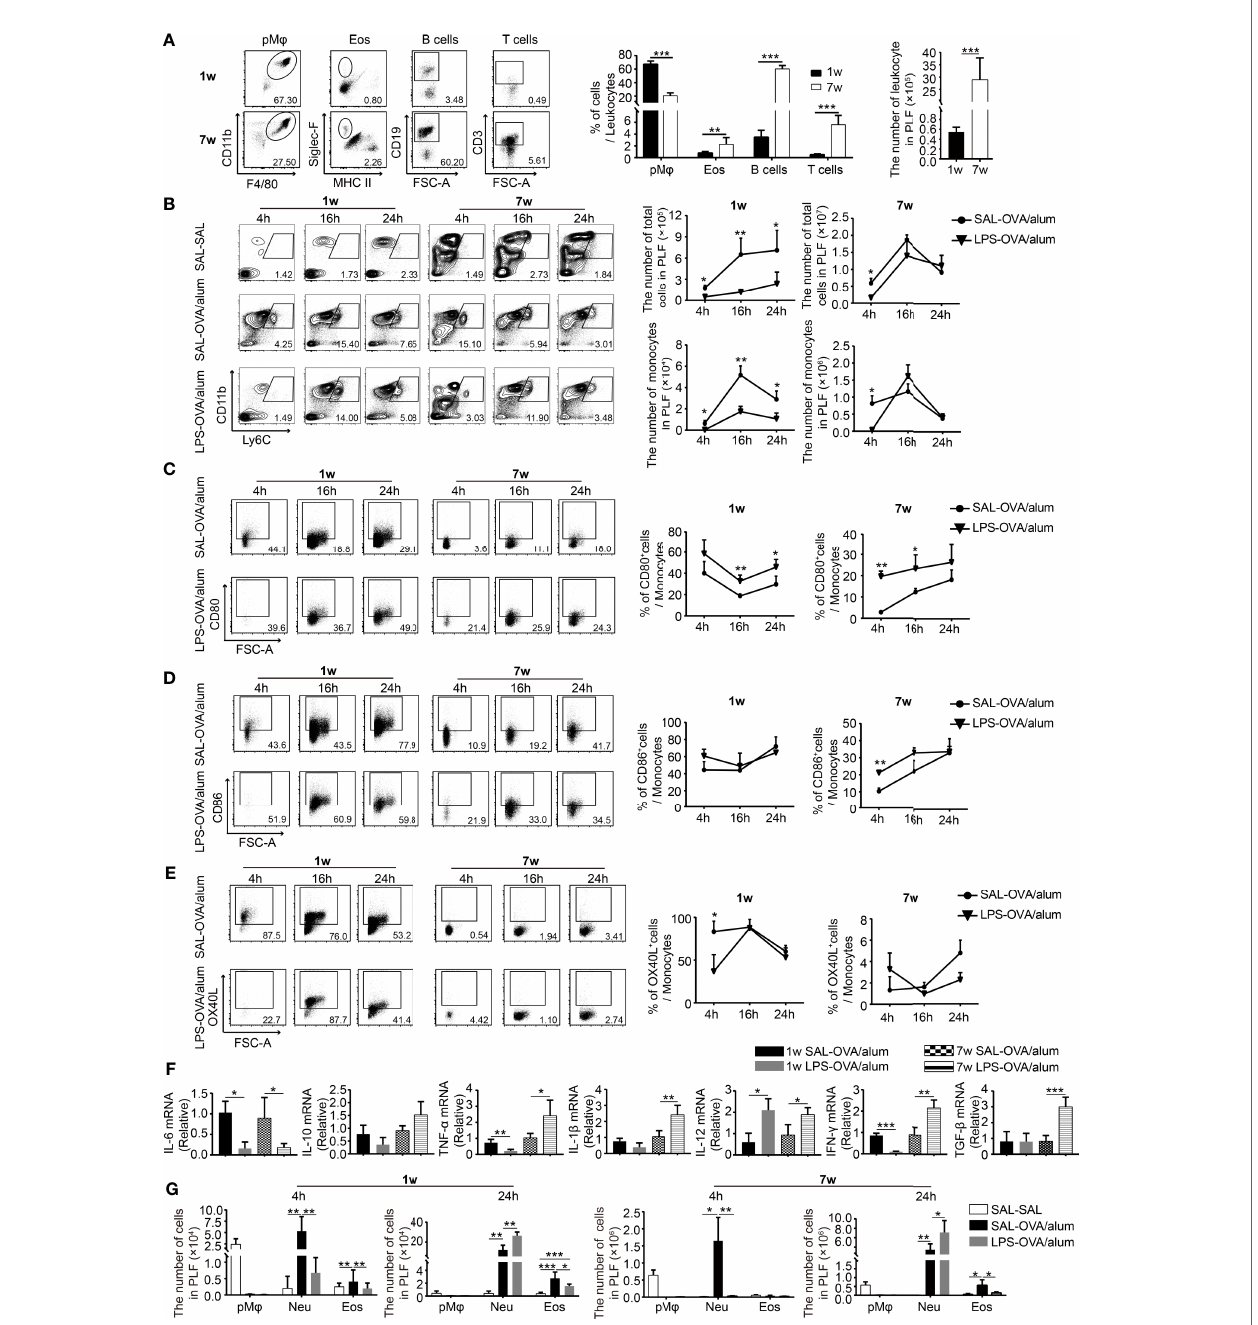
FIGURE 3 | Neonatal LPS treatment decreases the number of in fl ammatory monocytes in the peritoneal cavity. (A) At steady state, the constitution of pM j (F4/ 80 hi CD11b + SSC hi ), eosinophils (Siglec-F + MHC-II − SSC hi ), B cells (CD19 + SSC low ), and T cells (CD3 + SSC low ) in the peritoneal cavity of neonatal and adult mice ( n = 7 mice per group). (B – E) Neonatal and adult mice were injected i.p. with saline or LPS (1 m g) 1 h before OVA/alum sensitization. Four, 16, and 24 h after the fi rst OVA/ alum sensitization, the peritoneal lavage fl uid (PLF) was collected and the immune cells in the PLF were identi fi ed by fl ow cytometry. (B) The numbers of total cells and monocytes (Ly6C hi CD11b + ) in the PLF. The expression of CD80 (C) , CD86 (D) , and OX40L (E) on in fl ammatory monocytes. (F) The peritoneal in fl ammatory monocytes were puri fi ed as described in the Materials and Methods . The relative expressions of cytokine genes were determined by real-time PCR. (G) The numbers of pM j , neutrophils (Ly6G + CD11b + ), and eosinophils in the PLF. Data are representative of three independent experiments with n = 4 mice per group. Data are shown as mean ± SD. * P < 0.05, ** P < 0.01, *** P < 0.001. pM j , peritoneal macrophage; Neu, neutrophil; Eos, eosinophil; PLF, peritoneal lavage fl uid; SAL,